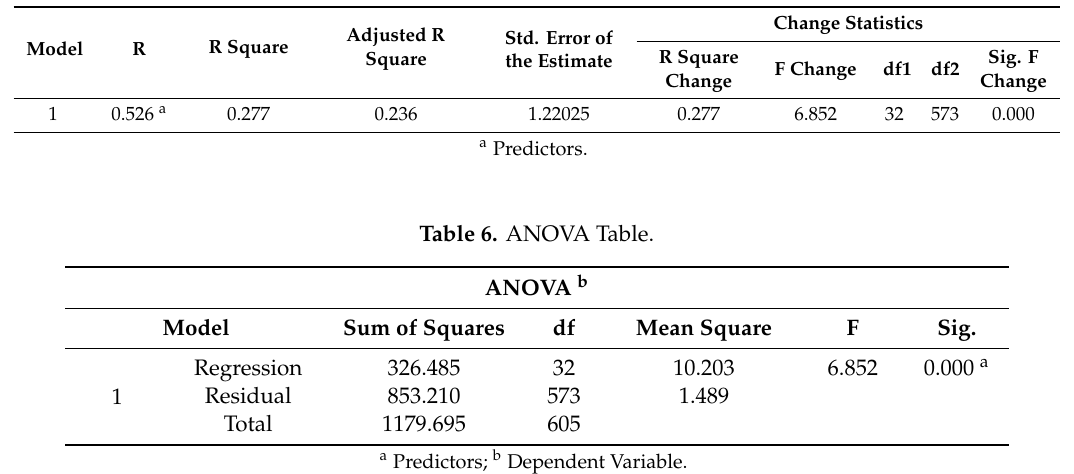
Table 5. Model Summary.